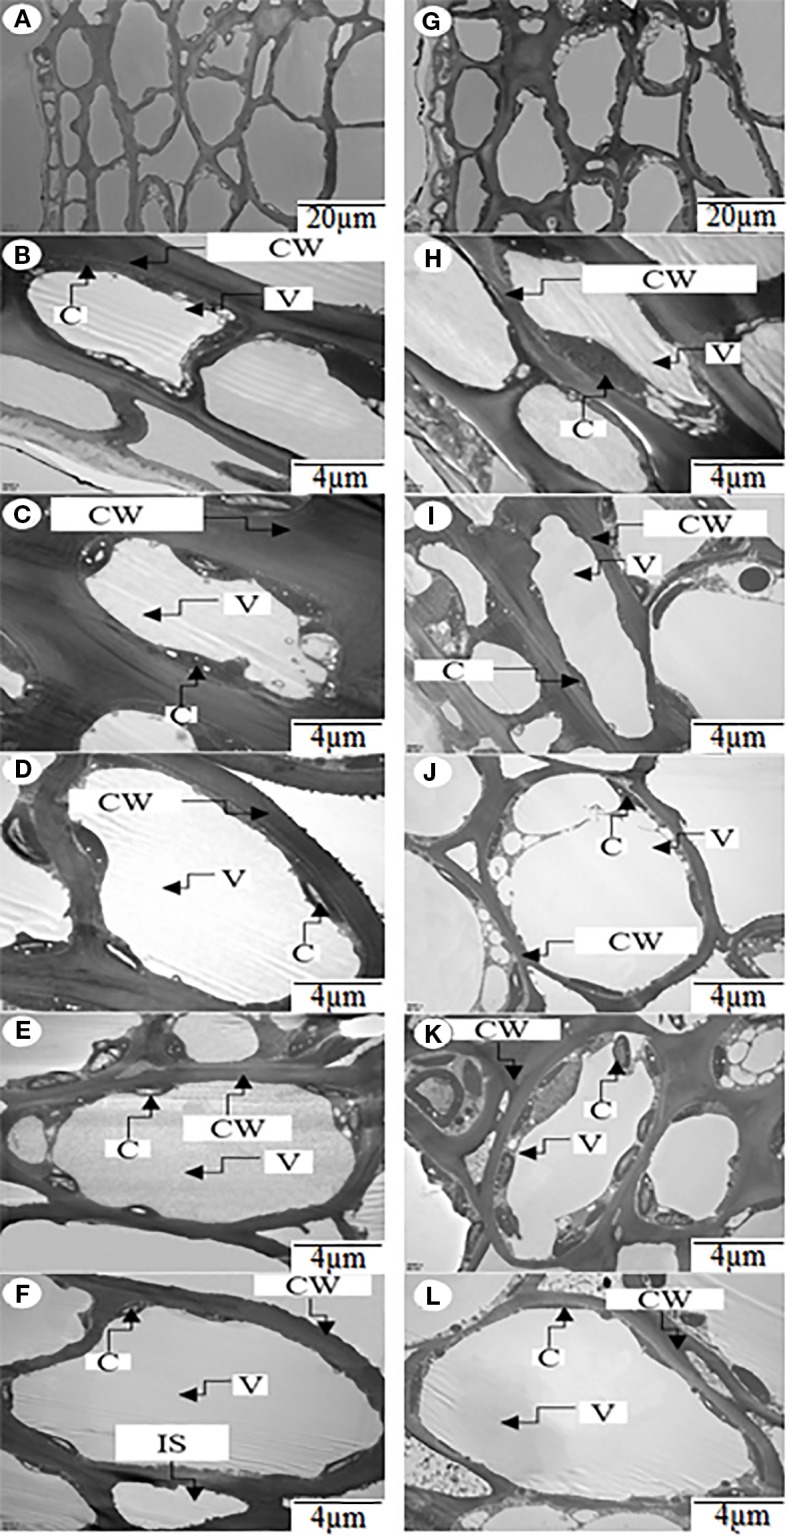
Ultrastructure of the chloroplasts in the zone from the first to the sixth cell layer of peels of hickory (Carya cathayensis) ph fruits (intraspecific pollination by hickory) and pp fruits (interspecific pollination by pecan) at 84 DAPS in 2017. (A), an overview of the first six cell layers of peel in ph fruits; (G), an overview of the first six cell layers of peel in pp fruits; (B– F), the ultrastructures of the chloroplasts in each of the second to the sixth cell layers of peel in ph fruits; (H–L), the ultrastructures of the chloroplasts in each of the the second to sixth cell layers of peel in pp fruits. CW, cell wall; C, chloroplast; V, vacuole.